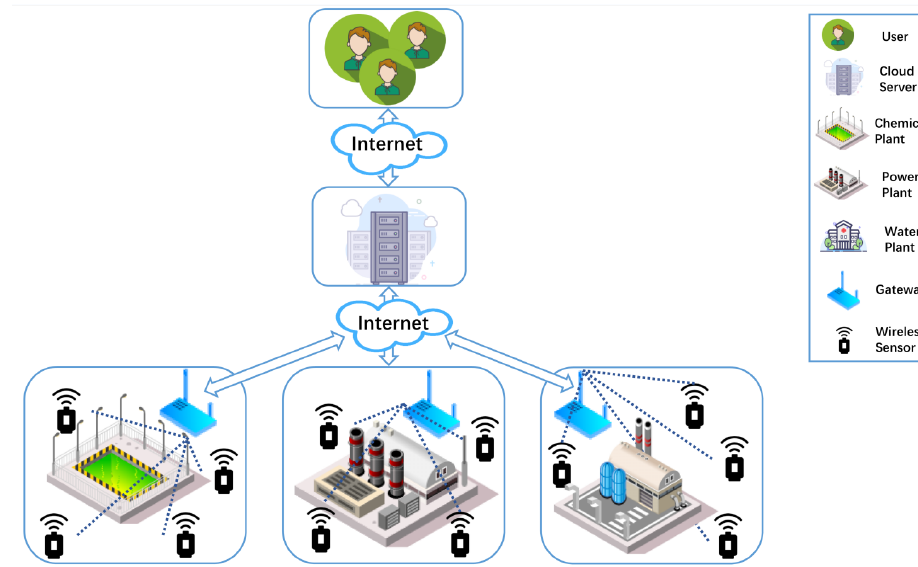
Figure 1. IIoT-oriented wireless sensor communication network model.